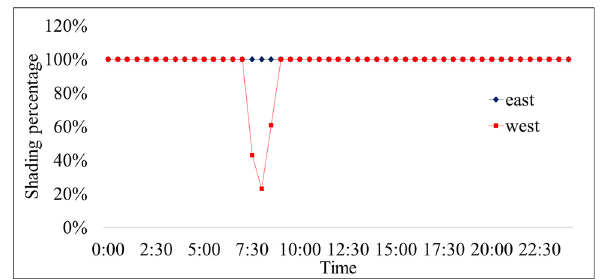
Figure 14. Solar shading percentage on November 27, 2016